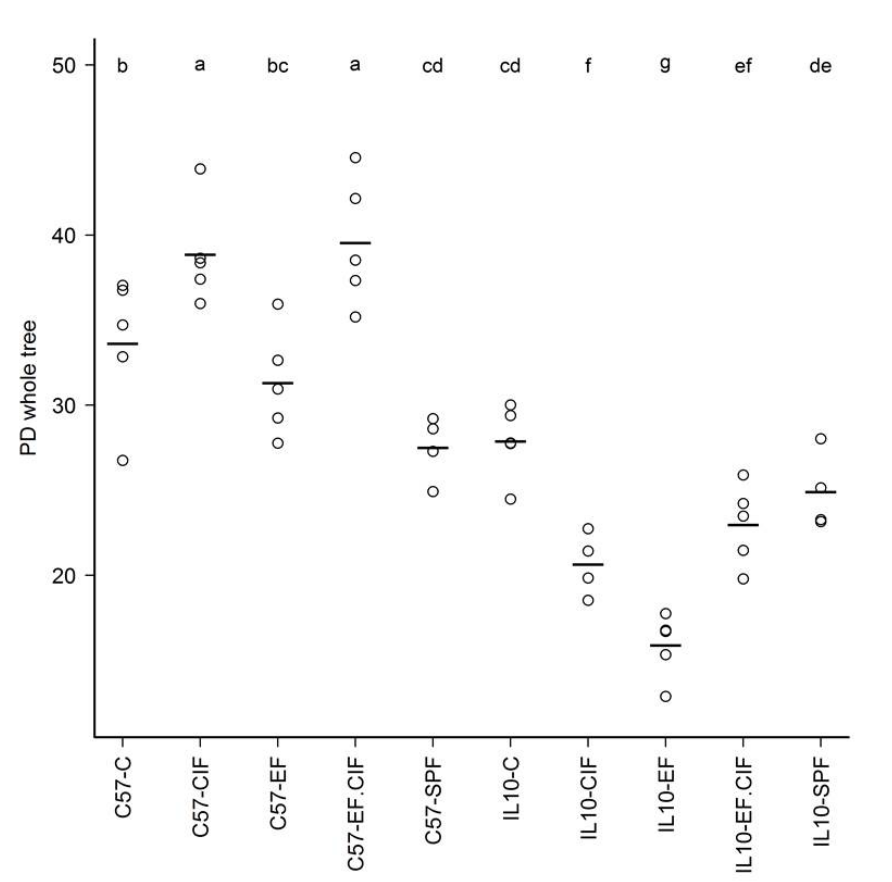
Figure 4. Faith’s Phylogenetic Diversity estimates of the caecal communities in C57 and Il10 -/- mice in treatment groups SPF, C, EF, CIF and EF.CIF. The higher the estimate, the greater the diversity. Lines indicate mean estimates and groups that differ significantly ( p < 0.05) are labelled with different letters. Mouse genotype/treatment groups are represented along the x